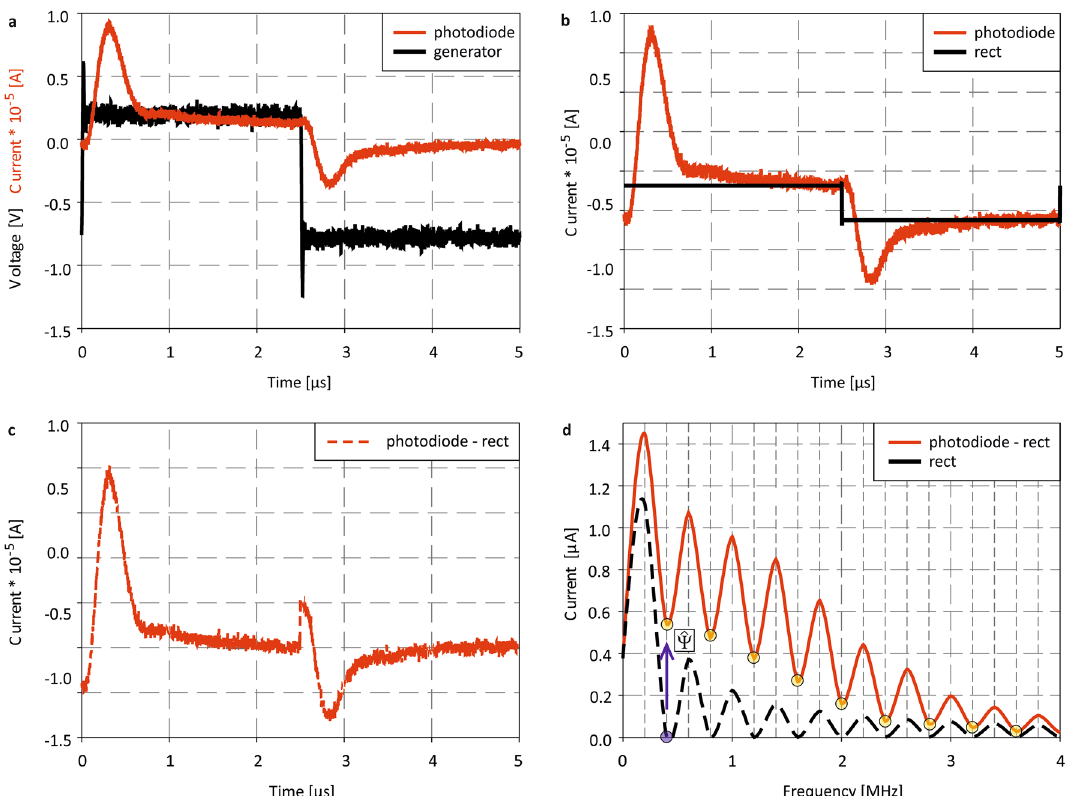
Figure 4. ( a ) Time domain signal of the a-Si:H FIP detector output (red) and rectangular modulation (black) at 200 kHz . ( b ) Time domain signal of the a-Si:H FIP detector output (red) and the 0 V bias , 477 nm and f mod = fitted, optimized sensor output (black). ( c ) Difference between the time domain signal with the fitted rectangular and ( d ) FFT of the signal shown in ( c ) (red line) and the rectangular output